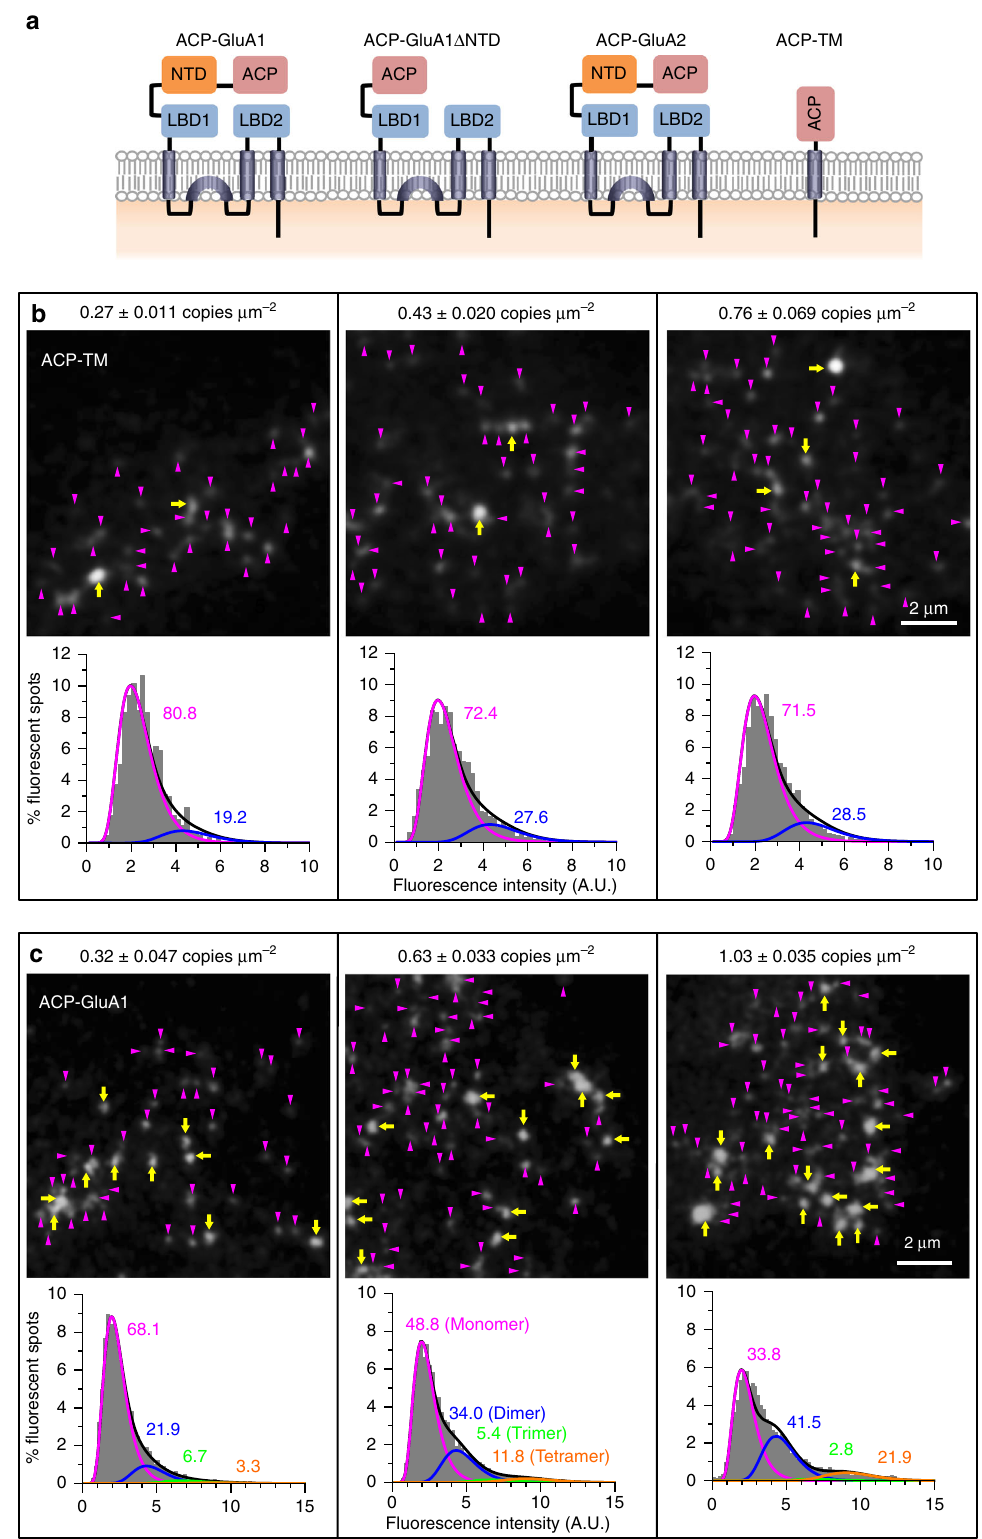
(A.U.)50 Fluorescence intensity functions (for fl uorescent spots representing monomers, and two, Fig. 3b; in the following, when the meaning is clear, we simply three, and four colocalized molecules), demonstrated that state GluA1 and GluA2 rather than ACP-GluA1 and ACP- considerable fractions of GluA1 and GluA2 molecules were GluA2). These results clearly showed that majorities of GluA1 monomers and homodimers, rather than homotetramers (Fig. 1c and GluA2 molecules exist as monomers. Quantitative evalua- bottom and Supplementary Fig. 3b bottom; Supplementary tions of the signal intensity distributions of individual GluA1 and Table 1). With an increase in the number densities of GluA1 GluA2 fl uorescent spots, using the sum of four lognormal